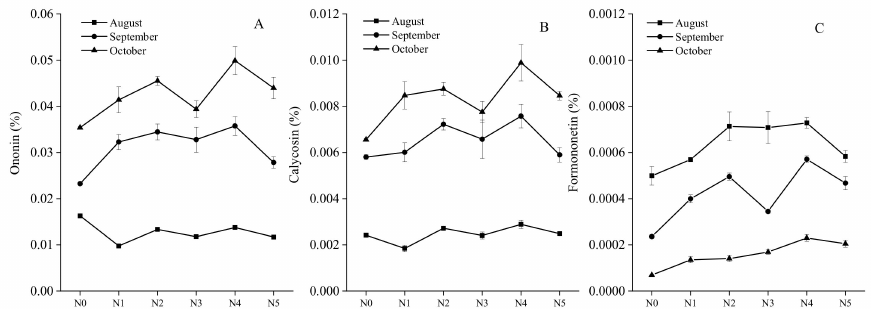
Figure 4. Ononin (%), calycosin (%), and formononetin (%) levels between di ff erent harvest stages from August to October (( A ) Ononin from August to October; ( B ) calycosin from August to October; ( C ) formononetin from August to October) under di ff erent nitrogen treatment levels: N0 = 0 kg / ha (unfertilized control), N1 = 37.5 kg / ha, N2 = 75 kg / ha, N3 = 112.5 kg / ha, N4 = 150 kg / ha, N5 = 187.5 kg / ha. Data represent means ± standard errors